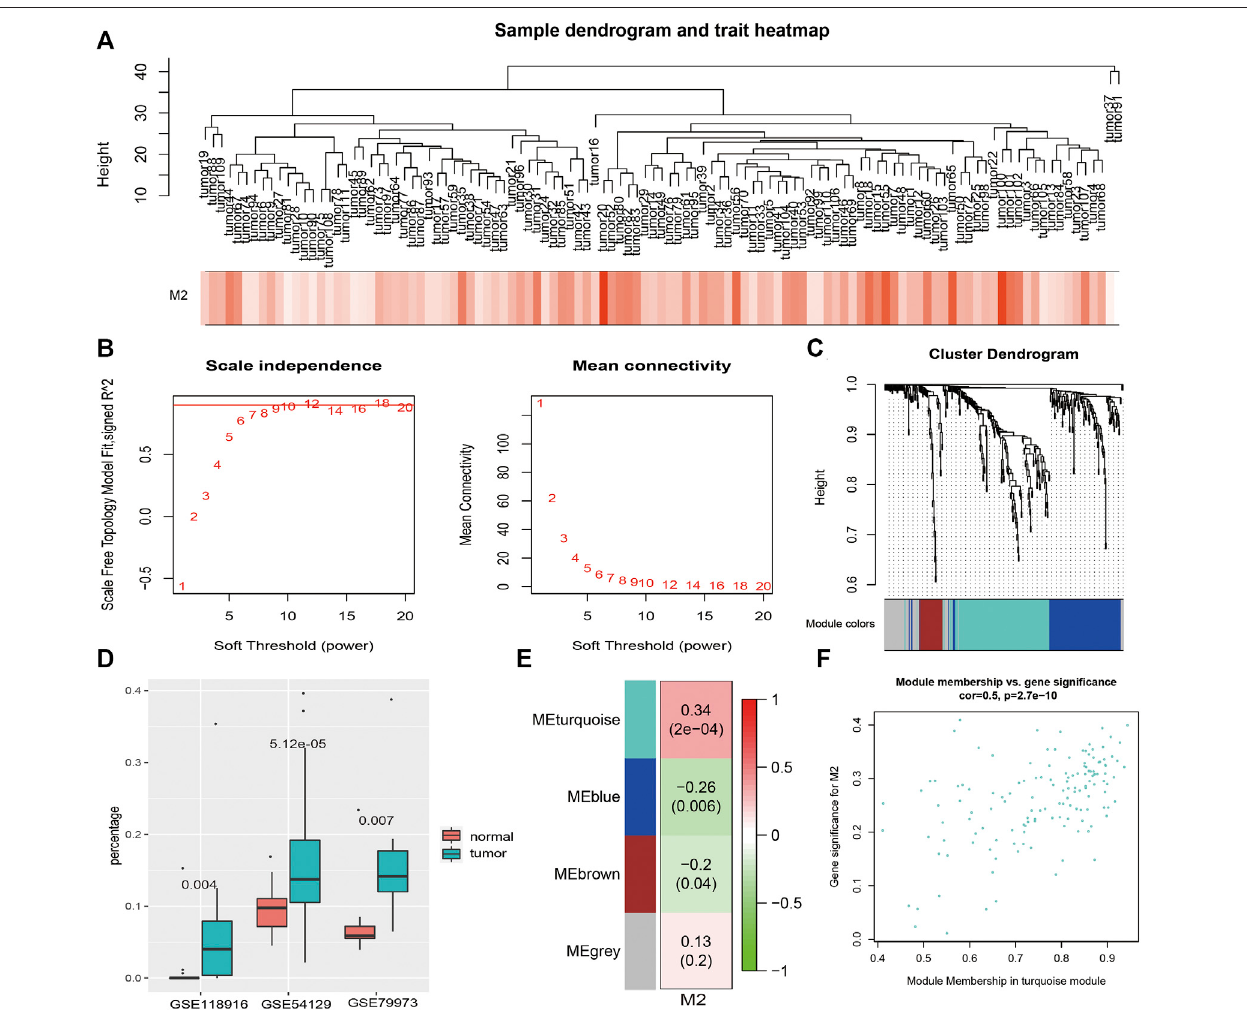
FIGURE 3 | WGCNA results. (A) . Sample clustering with macrophage M2 as the external trait. (B) . WGCNA power selection. (C) . Dendrogram of the WGCNA modules. (D) . The boxplot of macrophage M2 percentages between GC patients and controls in three datasets. (E) . The relationship between coexpression modules and external traits. (F) . The scatter plot of MM and GS in the turquoise